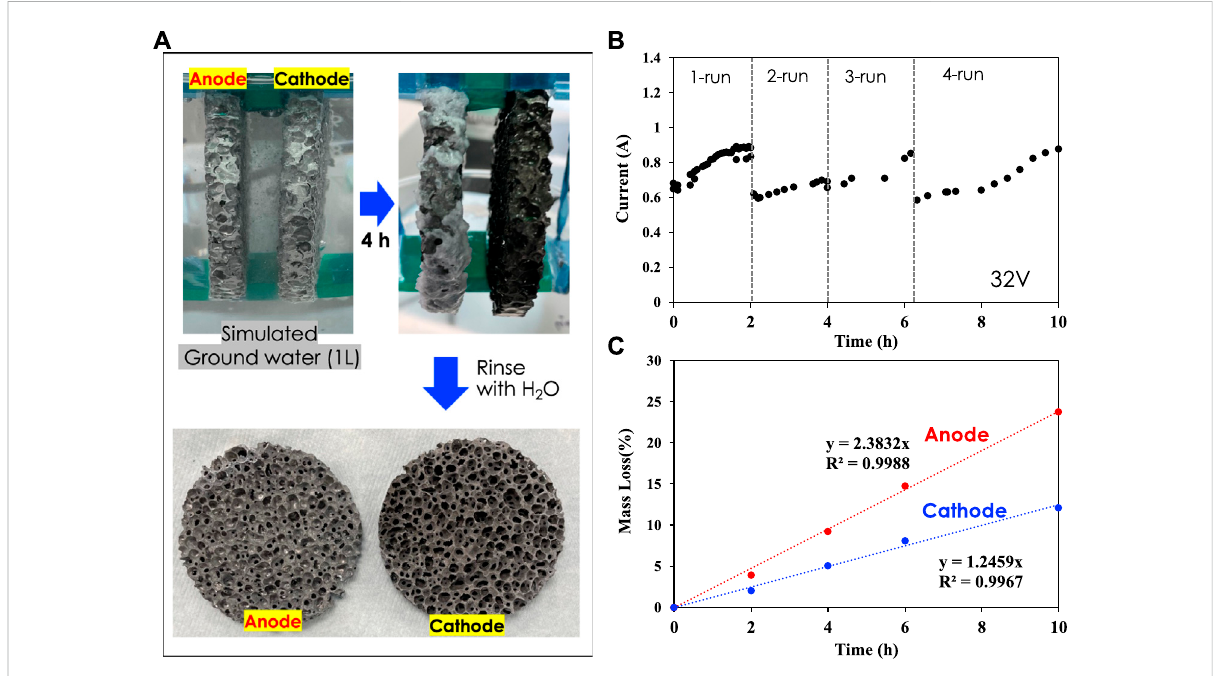
FIGURE 1 (A) ElectrocoagulationexperimentswithporousAlfoamelectrodes(3-inchdiameter)insimulatedgroundwater; (B) Electricalcurrentvs.timeat 32 V; (C) Mass loss of anode and cathode electrodes over time.